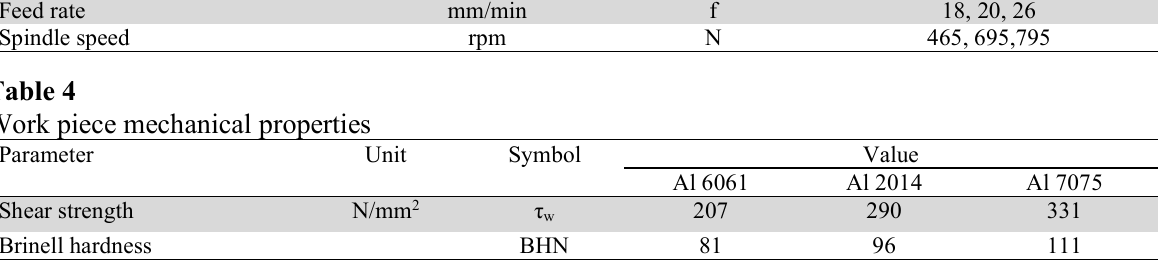
Machining parameters Parameter